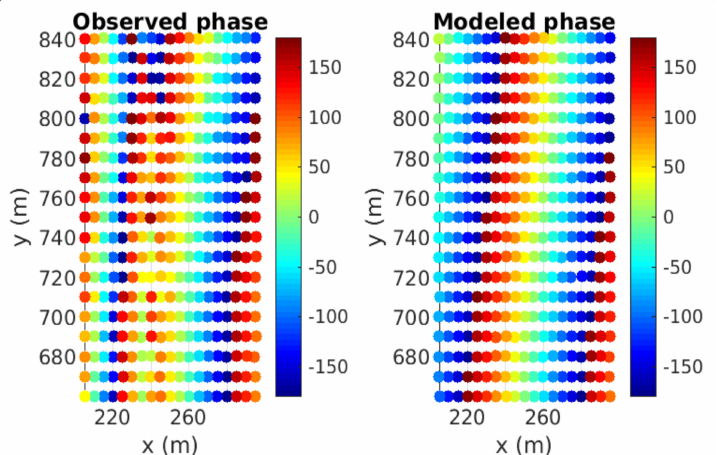
Figure 2. Phase map for the example tile shown in Figure 1 for the dominant frequency, f = 0.0956 Hz. Observed phase is on the left, best-fit modeled (Equation (2)) phase on the right. The x and y components of wavenumber are derived from the components of slope of the phase ramps (colors from seaward to landward going from blue through green, yellow then red with 360 ◦ phase jumps as blue–red